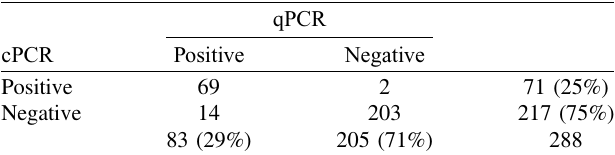
Table 3. Evaluation of fecal load of Blastocystis in human samples based on the established quanti fi cation curve (set in the range of 10 0 to 10 5 cells per 1 qPCR